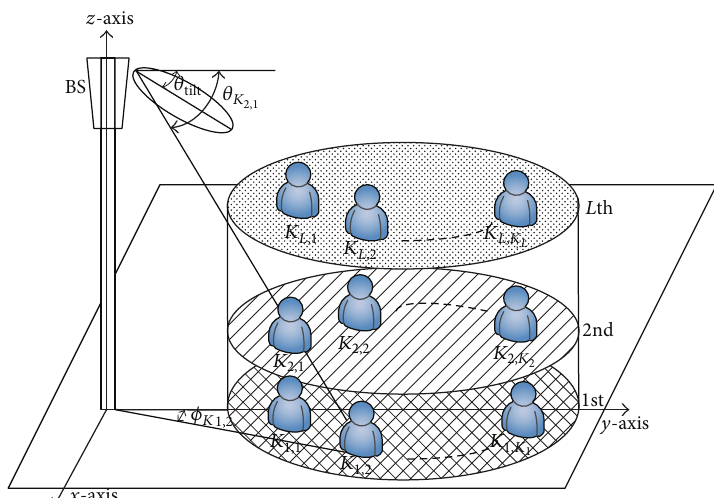
Figure 1: Schematic illustration of a D-MIMO